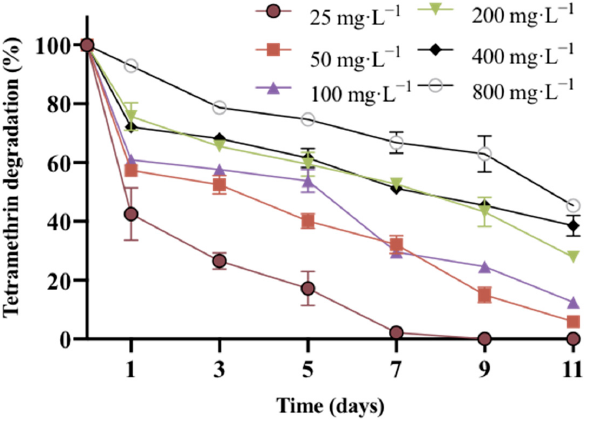
Figure 3. Degradation ability of strain A16 to tetramethrin at different concentrations.